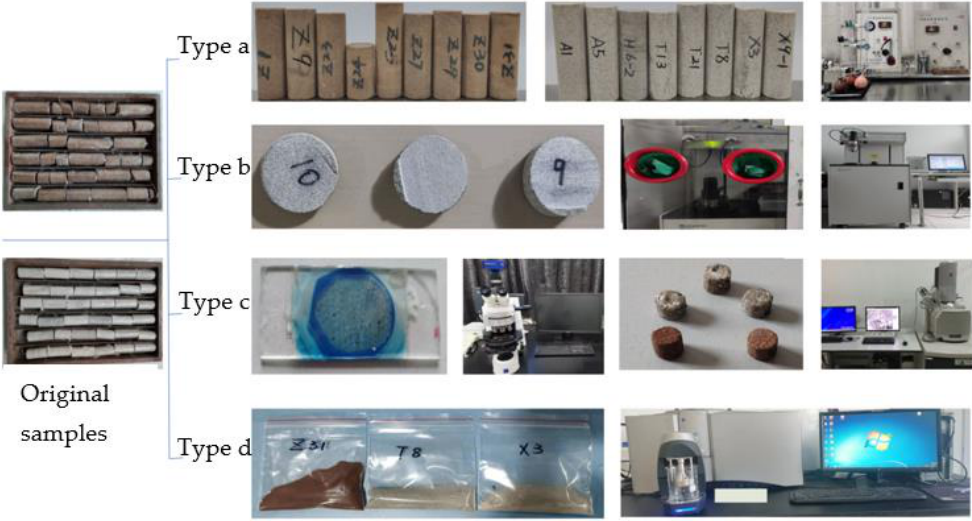
Figure 2. The original samples were processed to carry out four types of laboratory tests.